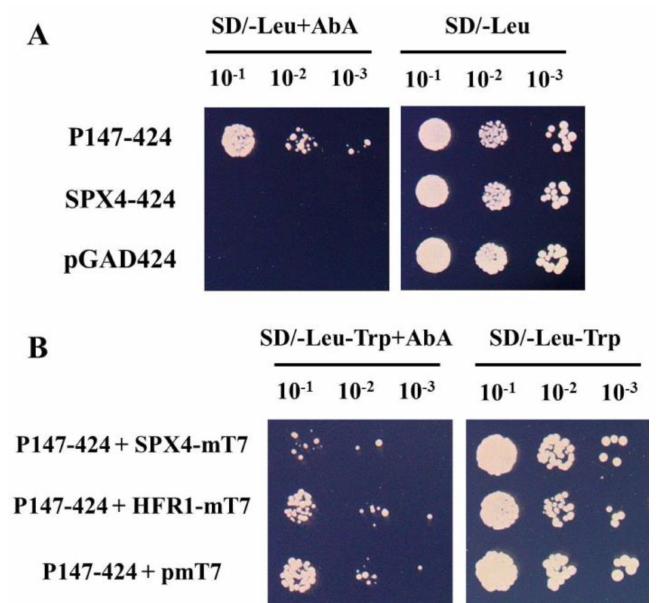
Figure 3. Interaction between SPX4 and OsPHR2-147 (P147) inhibited P147 binding P1BS element in yeast. ( A ) Y1H analysis of the binding of P147 to P1BS element. The P147 and SPX4 were cloned into pGAD424 (named P147-424 and SPX4-424, respectively), and transformed into reporter strains harboring the AbA resistance gene under the control of a synthetic promoter element consisting of a three repeats of the P1BS element from the OsIPS1 promoter (P1BS-specific reporter strain). Dilution series of yeast cells transformed with the indicated plasmids were grown for 4 days on synthetic complete medium lacking Leu (SD / -Leu, right), and medium lacking Leu but supplemented with 200 ng mL − 1 AbA (SD / -Leu + AbA, left). ( B ) The new method showing the inhibition of P147-P1BS binding by interaction between SPX4 and P147. SPX4-mT7, HFR1-mT7 and pmT7 were cotransformed with P147-424 into P1BS-specific reporter strain, respectively. Dilution series of yeast cells transformed with the indicated plasmids were grown for 4 days on synthetic complete medium lacking Leu and Trp (SD / -Leu-Trp, right), and medium lacking Leu and Trp but supplemented with 200 ng mL − 1 AbA (SD / -Leu-Trp + AbA,